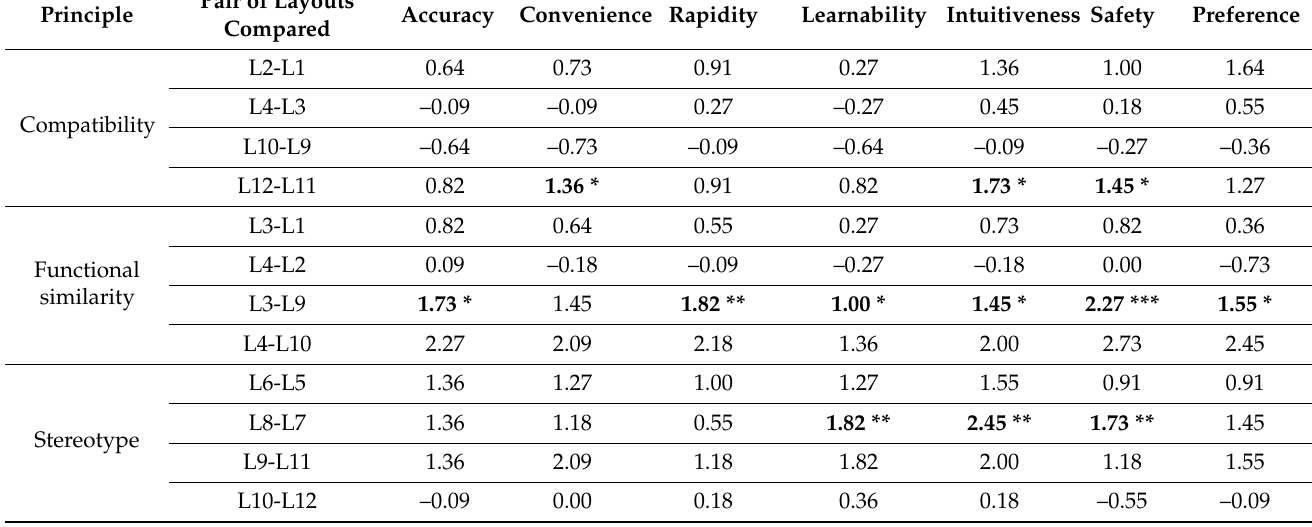
Table 8. Evaluation results for novice driver group: mean differences between layouts to which ergonomic principles were applied and layouts to which they were not